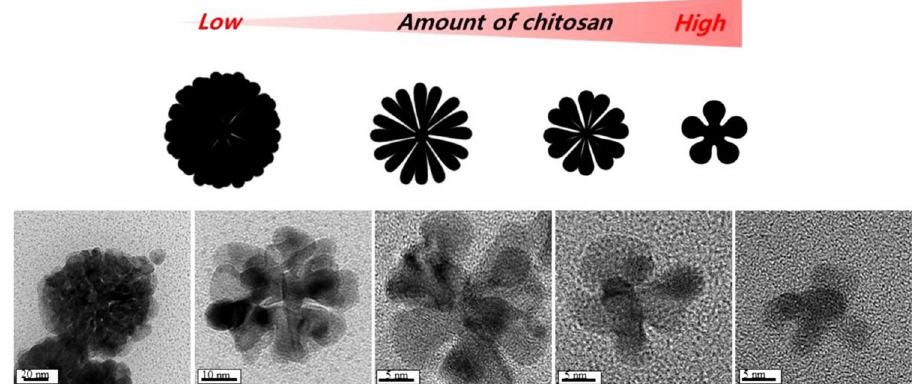
Figure 4: The TEM image of fl ower - shaped PdNPs, their size and shape dependence on the amount of chitosan. Ref. [ 32 ] Copyright 2019, Elsevier ™